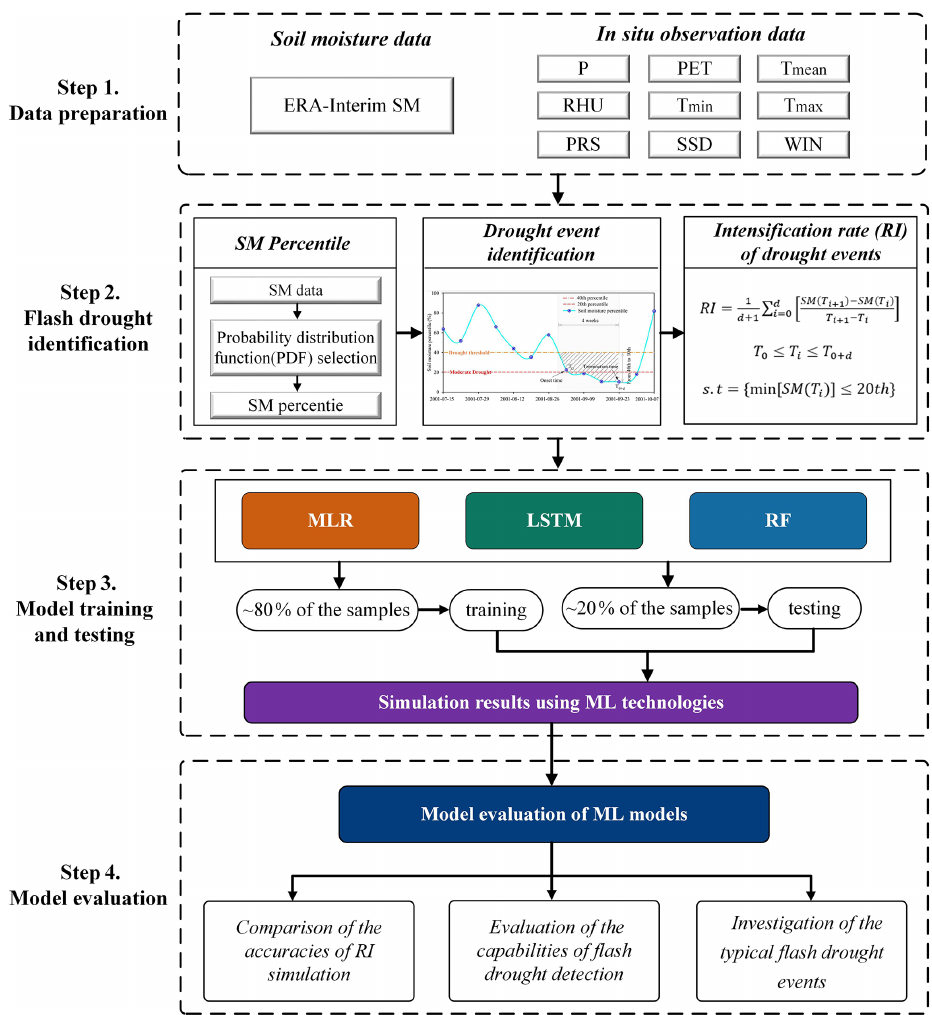
Figure 2. The flow chart of evaluating the performances of ML models for flash drought